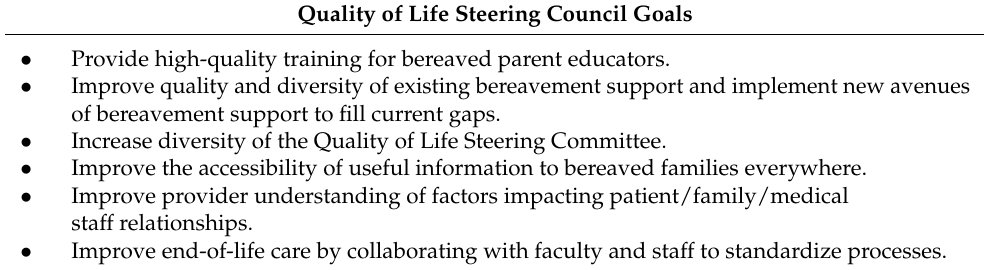
Table 3. QoLSC Strategic Planning Goals for